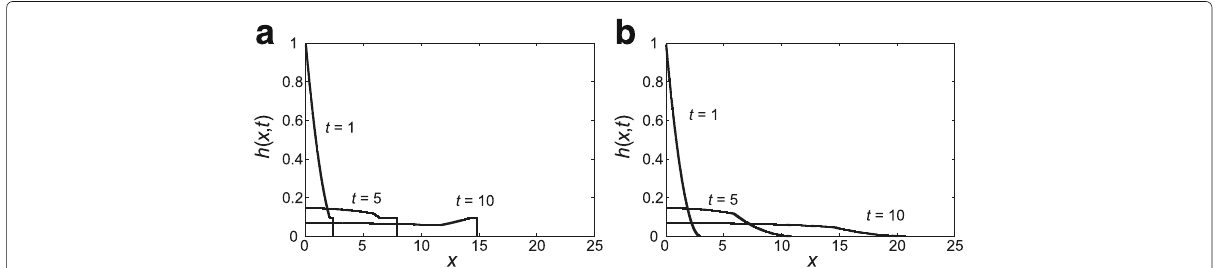
Fig. 9 Numerical results of h ( x , t ) for ρ c /ρ a = 10. a BC model. b AB model with ε = 1.0 × 10 − 10 . In ( b ), ρ c /ρ a = 10 is given when the basic equations (Eqs. (1) and (2)) are non-dimensionalized using Eqs. (4) and